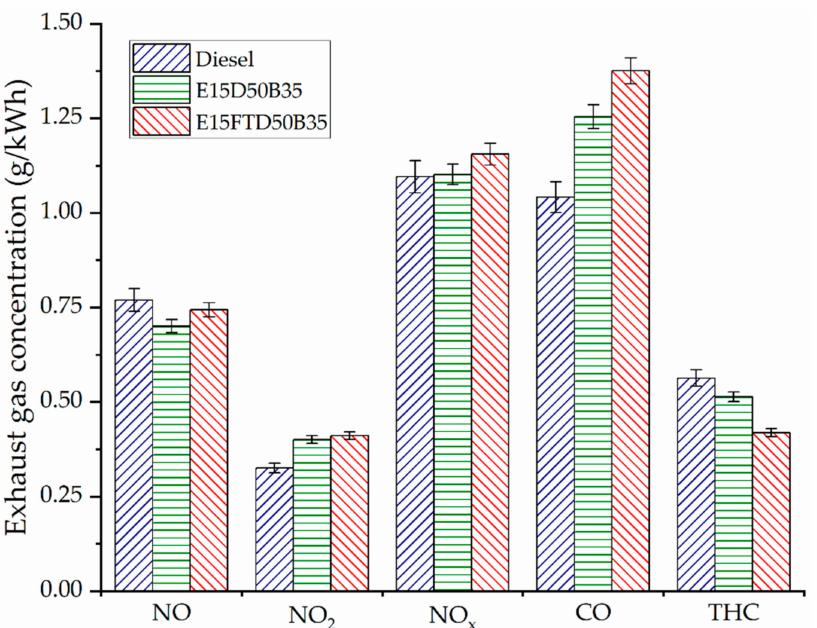
Figure 6. Effect of diesel, E15D50B35, and E15FTD50B35 on engine-out exhaust emissions at 2 bar IMEP and 1500